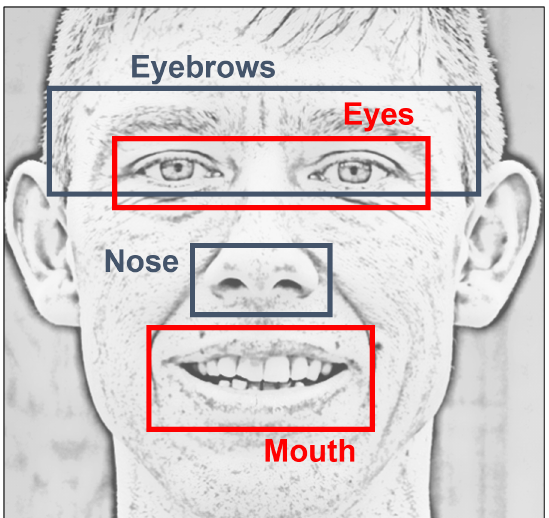
Figure 3. Example of a face image divided into four facial